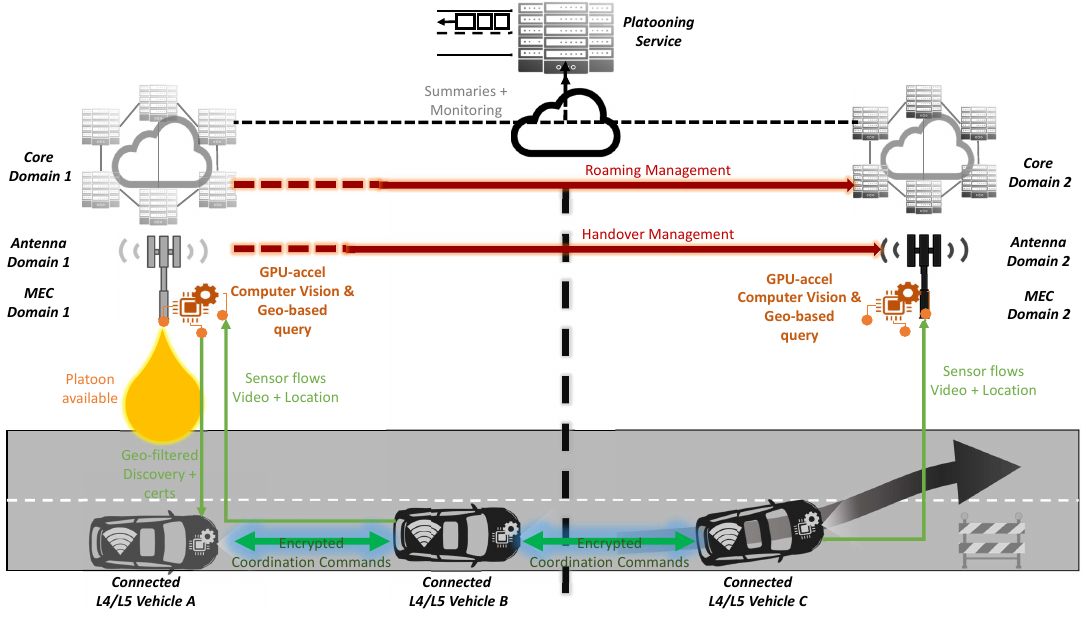
Figure 5. Platooning scenario of the proposed